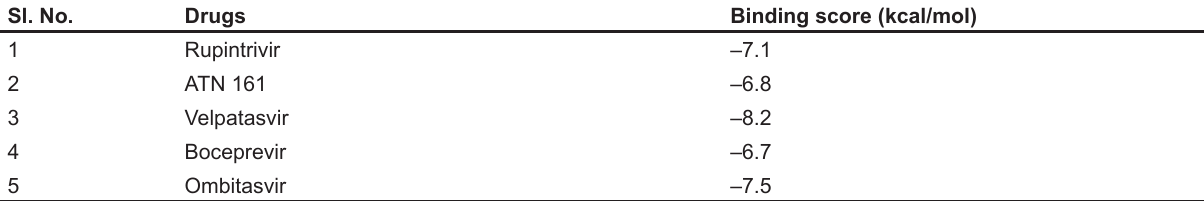
Table 2. Binding score of drugs against PDB ID 7P35 Sl. No.